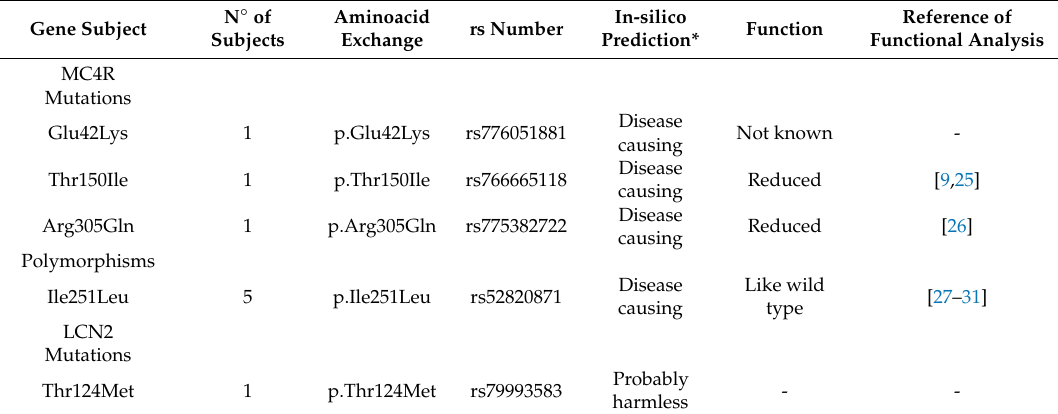
Table 1. MC4R and LCN2 genetic variants in Spanish children with abdominal